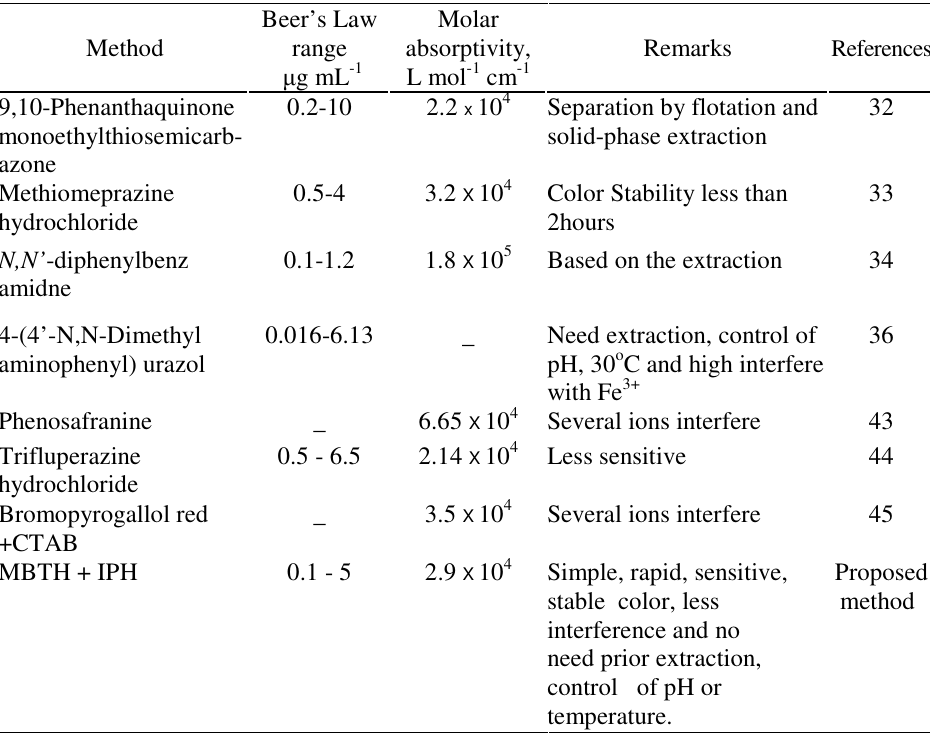
Table 5. Comparison of recommended method with reported